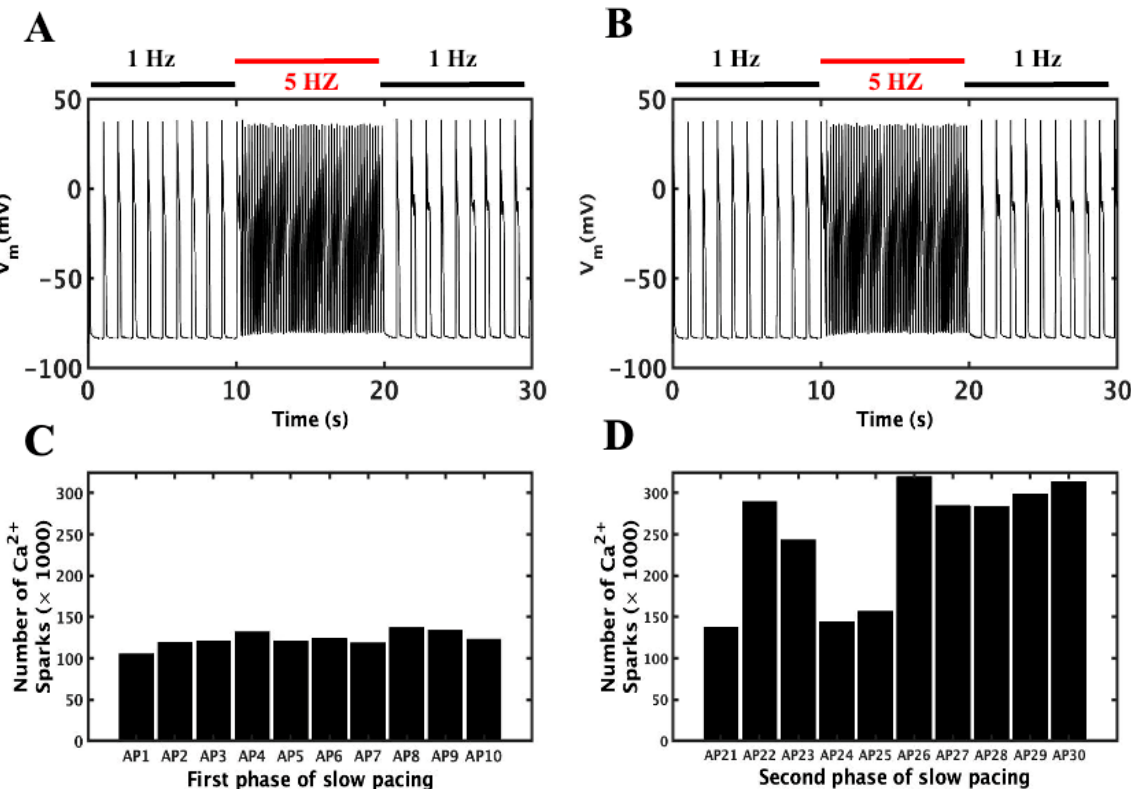
Figure 4. Slow–rapid–slow pacing in a CASQ2 G112+5X mutant myocyte generates EADs in the second phase of slow pacing during β -adrenergic stimulation. ( A ) β -adrenergic action potential simulation for 30 s in the mutant myocyte (1–10 s first phase slow pacing, 10–20 s rapid pacing, and 20–30 s second slow pacing phase). ( B ) β -adrenergic stimulation in WT myocyte with first and second slow phases with rapid pacing in the center. For the simulation in A, the number of Ca 2+ sparks were counted and compared in the first phase slow pacing ( C ) and second phase slow pacing ( D ) after the rapid pacing. The huge difference in their number of sparks before and after the rapid pacing represents the increased SR load right after the rapid pacing. A two-tailed Student’s t -test unequal variance finds that the mean number of sparks are unequal in panels ( C , D ) with p < 0.001. The simulation was repeated 10 times with different seeds for the pseudo random number generator and the patterns observed were repeated each time. Shown here is a representative